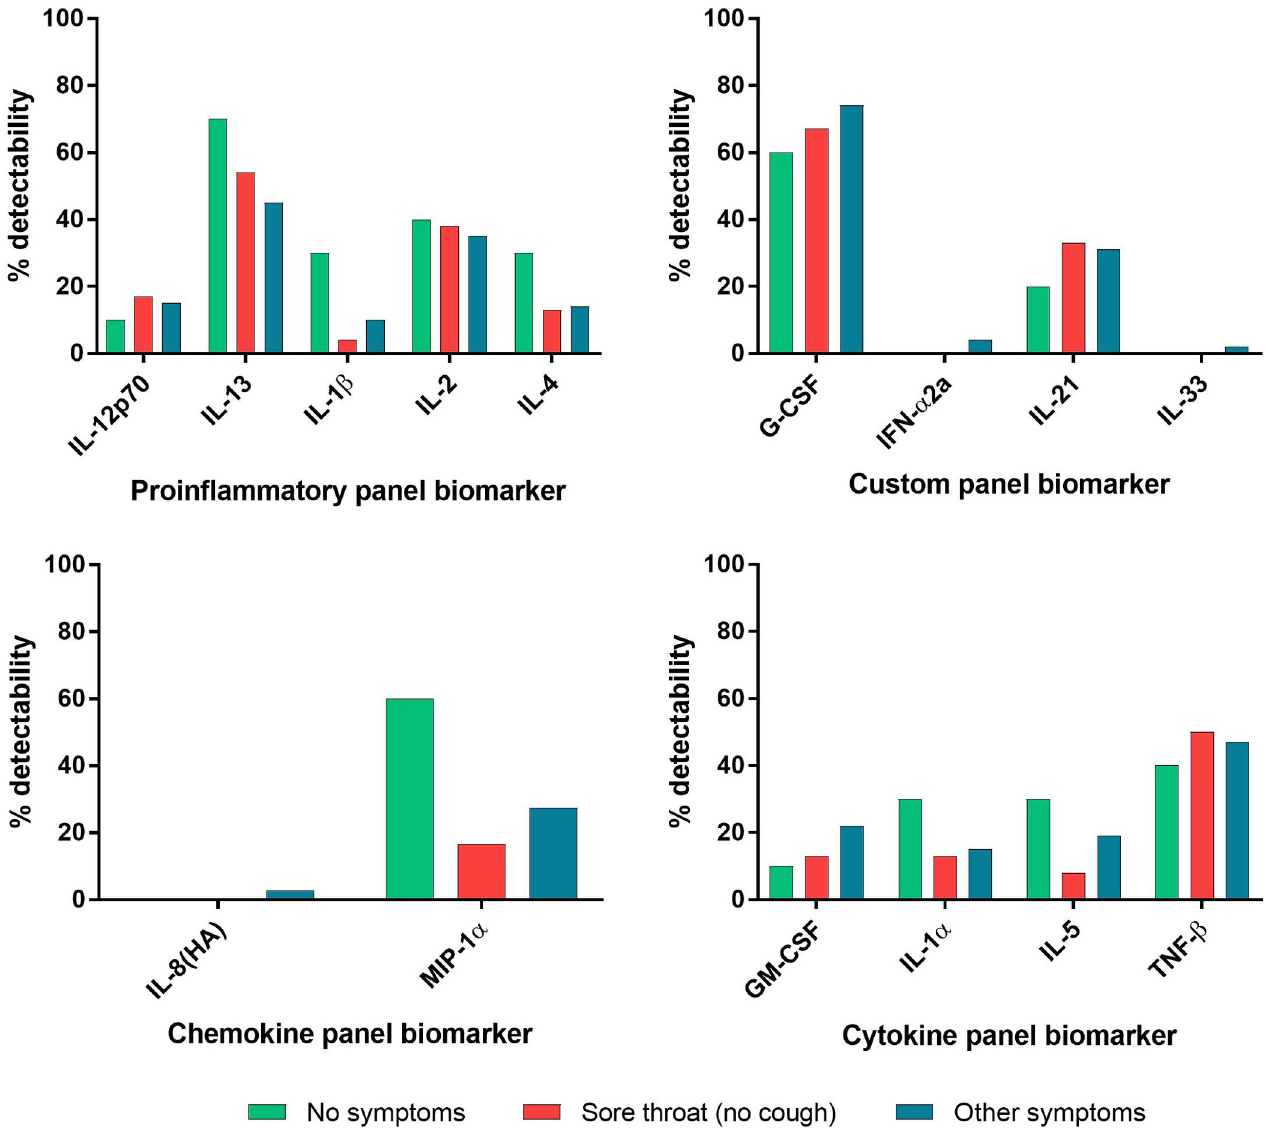
Fig 5. Detectability of cytokine and chemokine markers by response panel and symptom group. Cytokine and chemokine analytes with < 80% detectability in the overall participant group are shown according to MSD panel. Individuals reporting no symptoms (n = 10), sore throat and no cough (n = 24), and all other symptoms (n = 182) are shown in green, red, and blue,